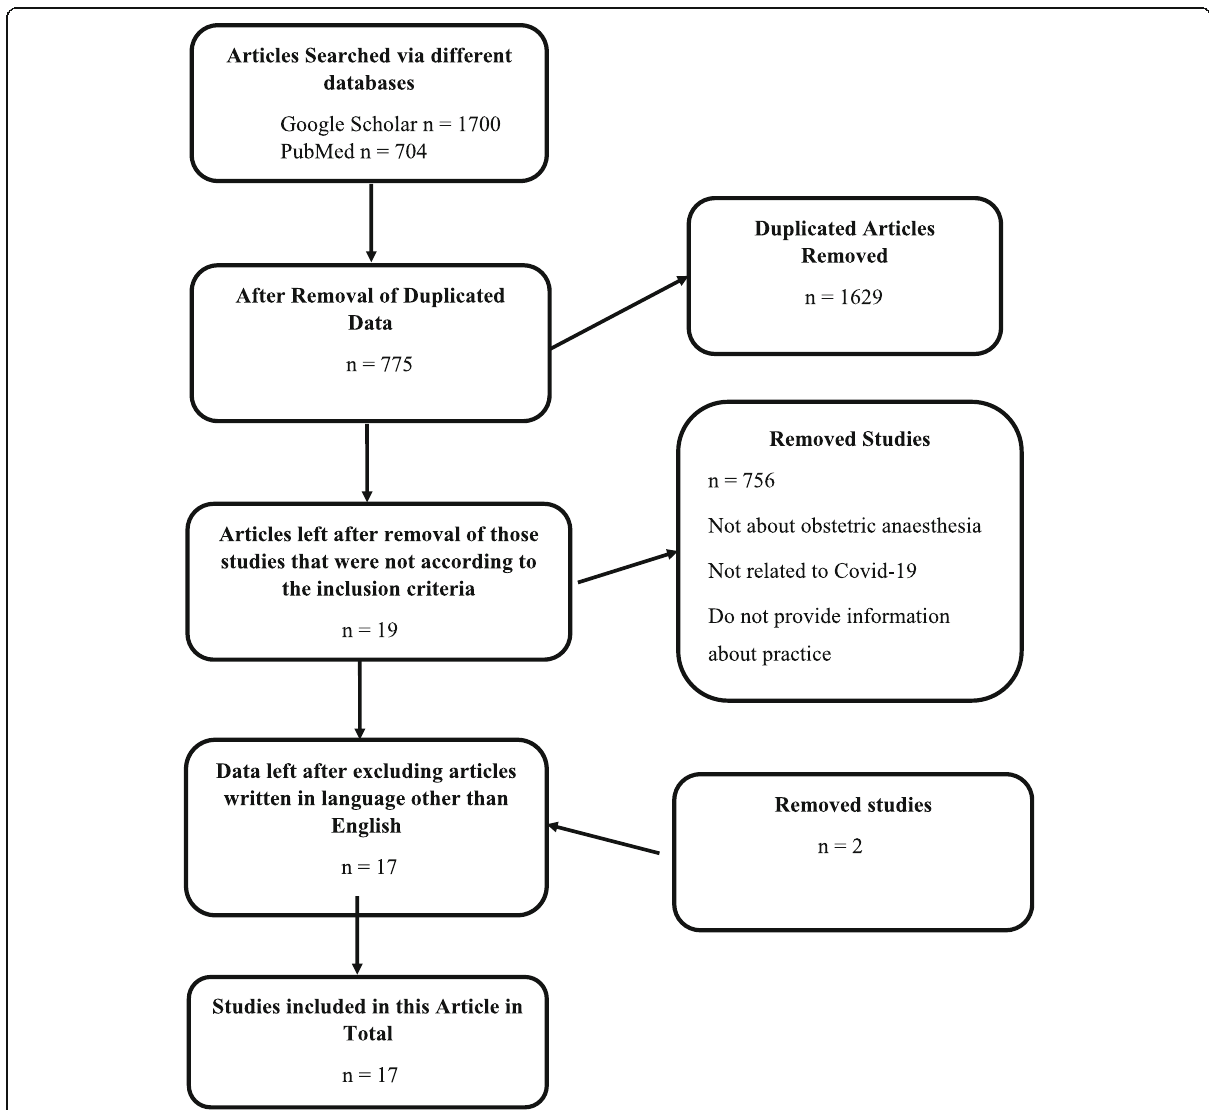
Fig. 1 Summary of the searched information and the method selected for data